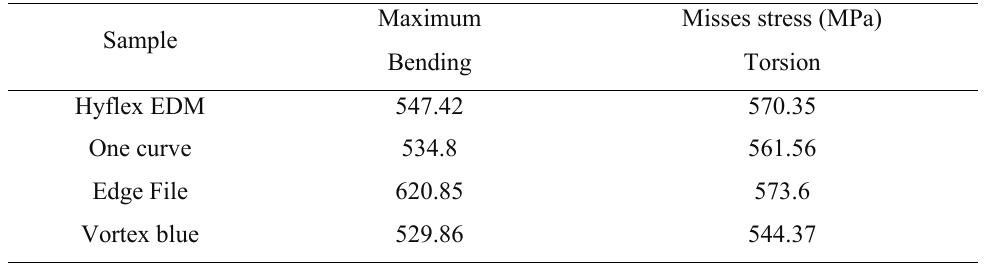
Table 1: Von Mises stress levels of NiTi Table 1. Von Mises stress levels of